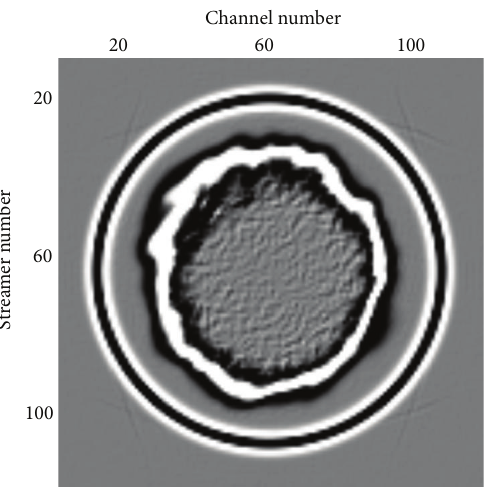
Figure 2: Time slice of the total pressure wavefield taken at time 0.5 s for hydrophones placed at 20 m